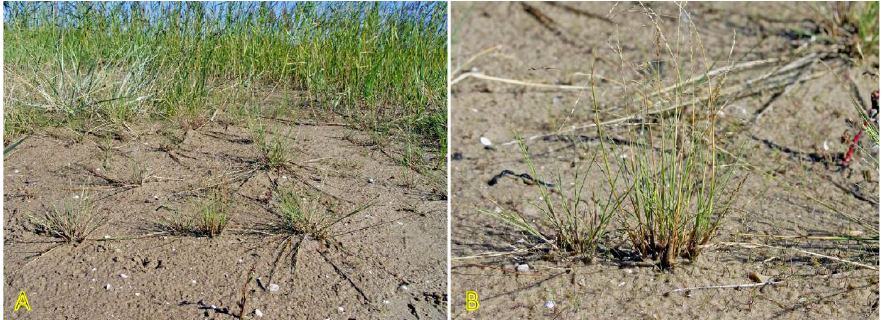
Figure 3. Puccinellia maritima plants on a wet sandy beach together with Leymus arenarius and Phragmites australis ( A ), genet with characteristic clonal architecture, and ( B ) in Lielupe, Jūrmala, Latvia. Not much experimental evidence is available on the salinity tolerance of P. maritima or P. distans . In hydroponic conditions, the survival rate of P. maritima was 55.0% at 10 g